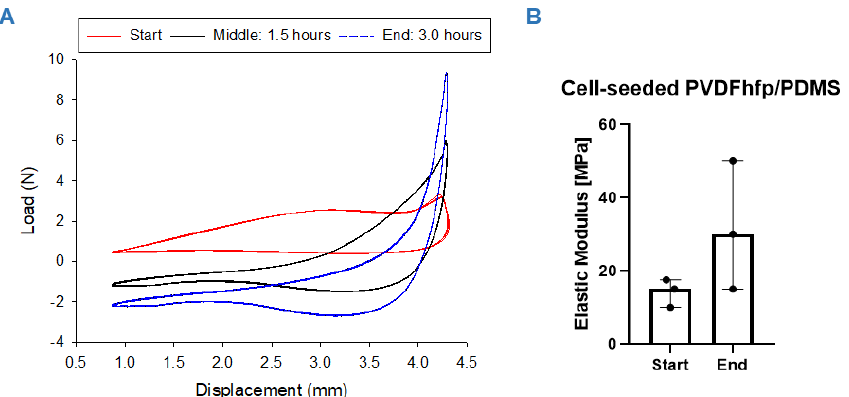
Figure 4. Mechanical properties: Load elongation curves for hASC cell-seeded PVDFhfp/PDMS scaffolds during the 3-h stretching regimen; at the beginning (start: 0 h) ( A , red curve), in the middle of the experiment (middle: 1.5 h. 5400 cycles) ( A , black curve) and at the end (end: 3.0 h, 10,800 cycles) ( A , blue curve). Elastic modulus increased during the experiment, with p = 0.25 for n = 3 ( B ). Paired t test was used to analyze the elastic modulus data; data are shown as median and interquartile range.